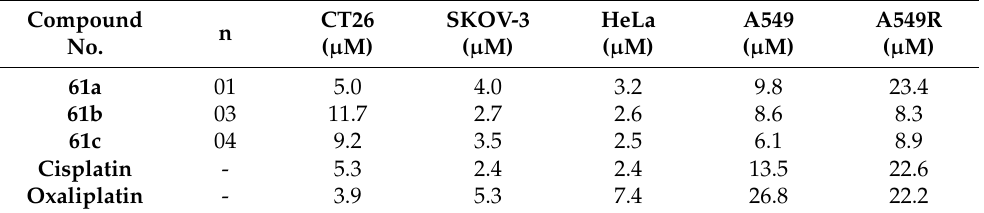
Figure 64. Structure of Platinum (iv) dihydro ‐ 2 ‐ quinolone hybrid derivatives ( 61 ). Table 51. In vitro cytotoxic activities of Platinum (iv) dihydro ‐ 2 ‐ quinolone hybrid compounds 61 ( a – Table 51. In vitro cytotoxic activities of Platinum (iv) dihydro-2-quinolone hybrid compounds 61 ( a – c ). c ). Compound